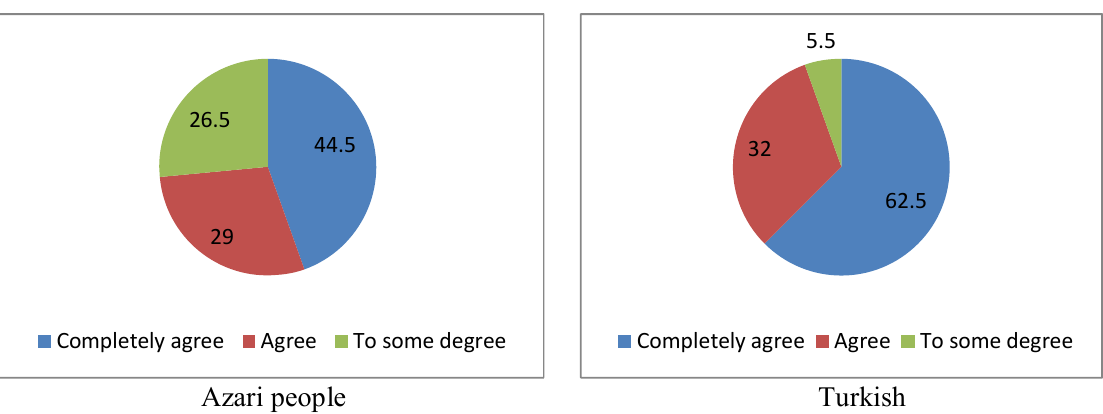
Fig. 3. The level of Religious believes